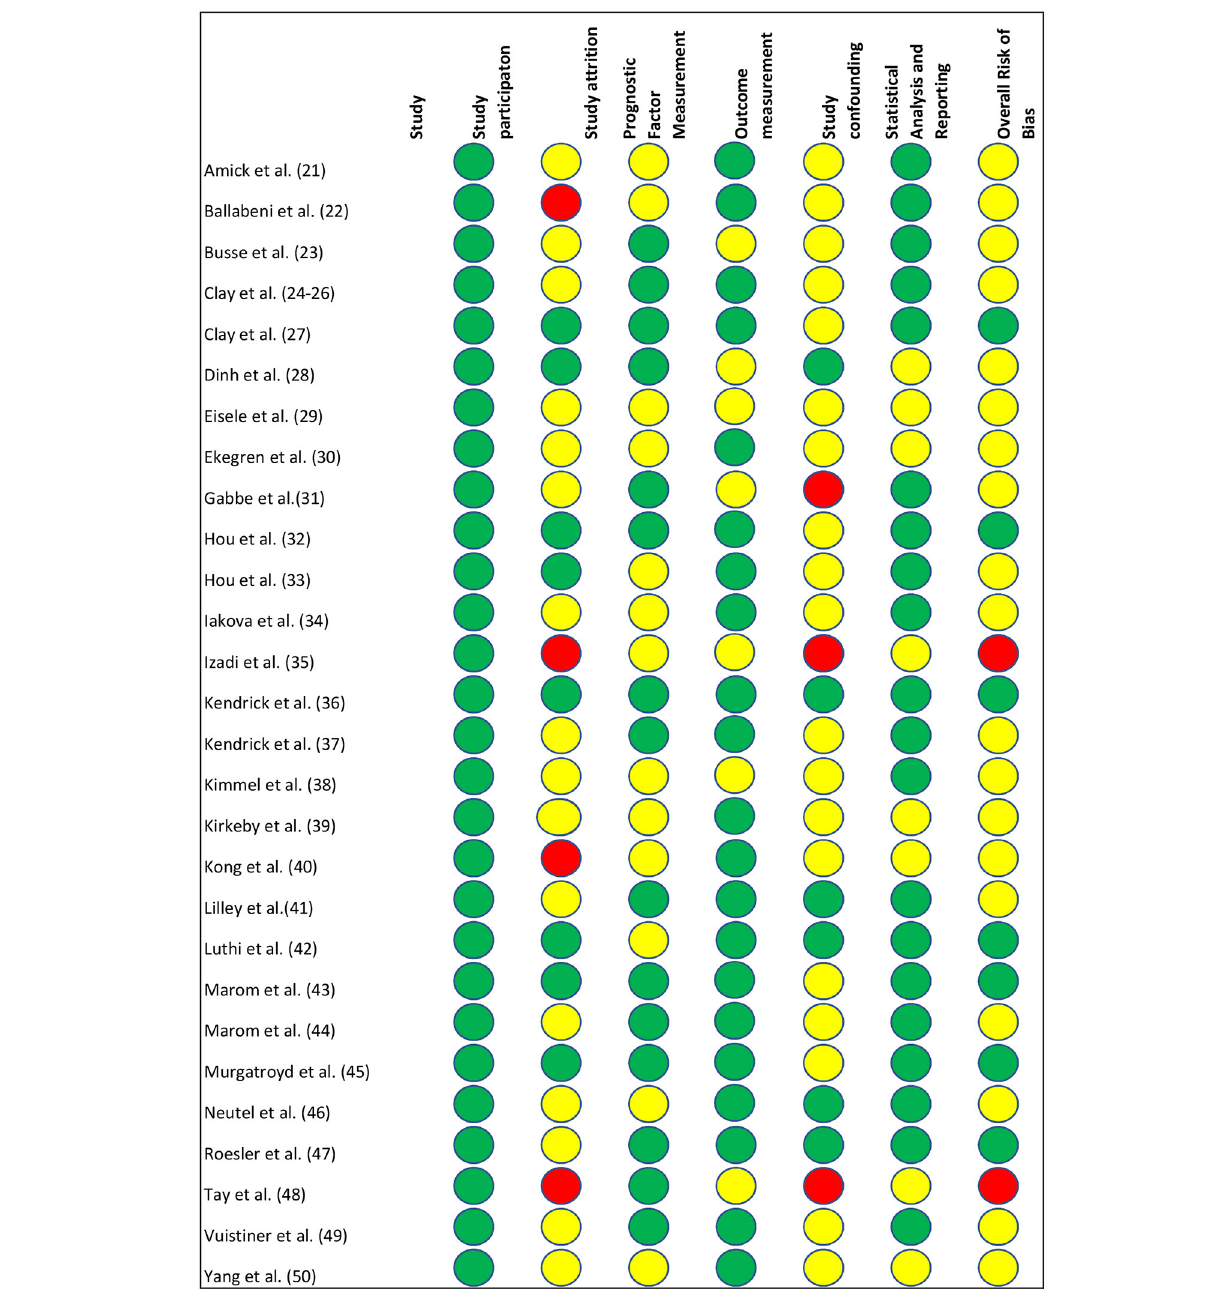
FIGURE 2 | Risk of bias according to the Quality in Prognosis Studies (QUIPS) tool. Red circle = high risk of bias, yellow circle = moderate risk of bias, green circle = low risk of